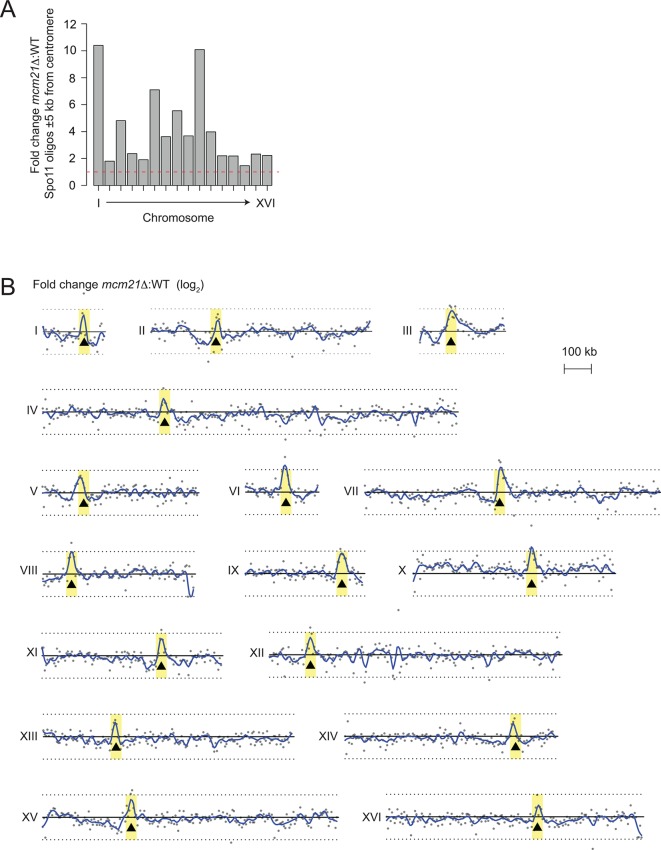
Genome-wide view of meiotic recombination initiation in the mcm21△ mutant.(A) Fold change in mcm21△ over wild type of Spo11-oligo counts (RPM) in the 10 kb encompassing each centromere. Red dashed line indicates fold change of one. (B) Whole-chromosome view of changes in the Spo11-oligo distribution in mcm21△ . Each point is the fold change (plotted on log2 scale) of mcm21△ over wild type Spo11 oligos (RPM) summed in 5-kb bins. Blue lines, smoothed fit (loess); black triangles, centromeres; yellow shading, centromere ± 20 kb; black solid line, 0 (log2 scale) indicating no change over wild type; black dotted lines, 2-fold change (log2 scale). RPM, reads per million mapped.